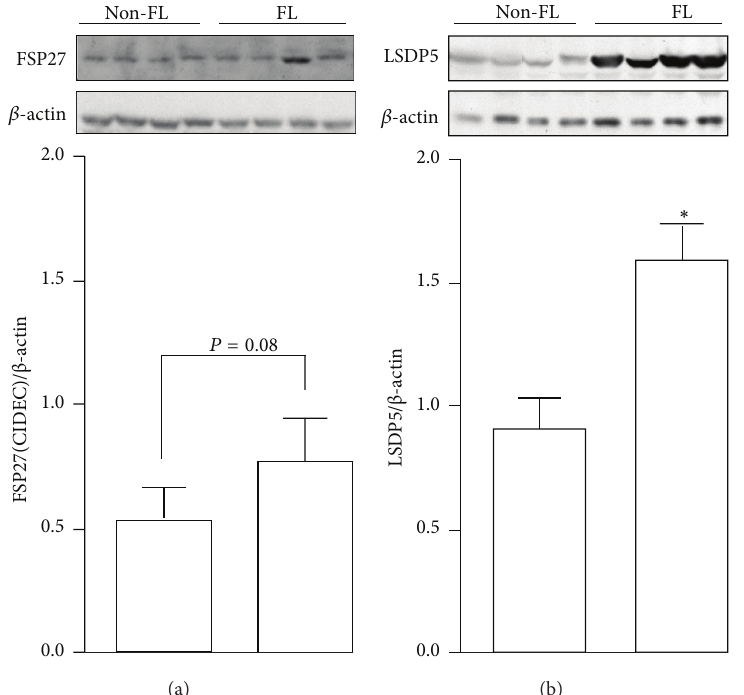
Figure 3: FSP27/CIDEC and LSDP5 protein expression increased in human fatty liver. Immunoblot analyses of FSP27/CIDEC (a) and LSDP5 (b) protein expression (upper panel) from human liver tissue samples with or without fatty liver. Quantification of the protein levels was normalized to 𝛽 -actin (lower panel). Data are the mean ± SEM ( 𝑛 = 4 ). ∗ 𝑃 < 0.05 . Non-FL: subjects without fatty liver and FL: subjects with fatty